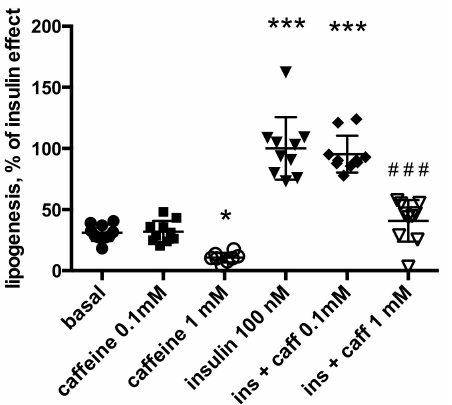
Figure 4. Caffeine inhibits basal and insulin-stimulated lipogenesis in mouse adipocytes. Data expressed as percent of maximal lipogenic response to insulin. The 100% indicates the mean glucose incorporation into lipids stimulated by insulin 100 nM found in ten different preparations of mouse adipocytes. Each condition was successfully tested in 10 adipocyte preparations, save for caffeine 1 mM alone (open circles), for which n = 8. Significance was determined compared to basal lipogenic activity (control, black circles) at: * p < 0.05, *** p < 0.001. Significant difference from insulin without caffeine (ins, inverted triangles) at: ### p < 0.001).